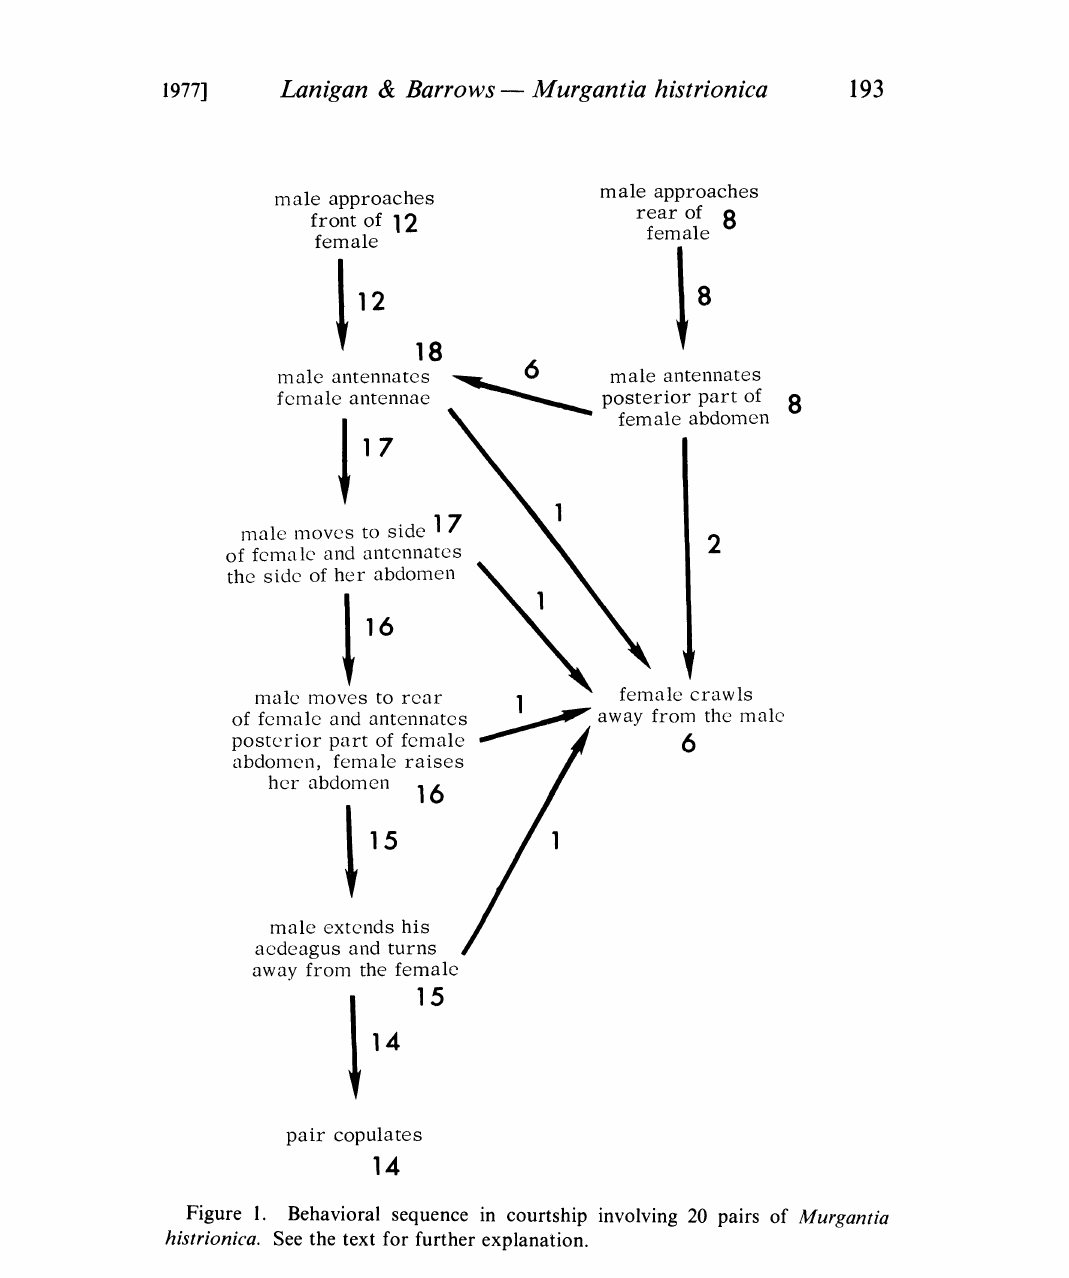
Figure 1. Behavioral sequence in courtship involving 20 pairs of Murgantia histrionica. See the text for further